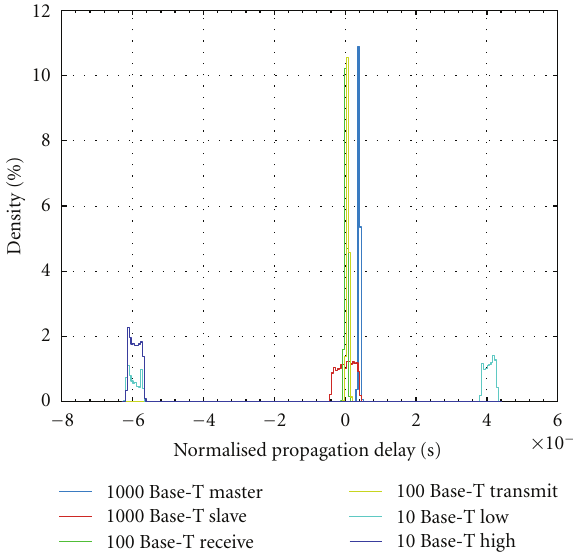
Figure 3: Comparison of various Ethernet physical layer transmis- sion